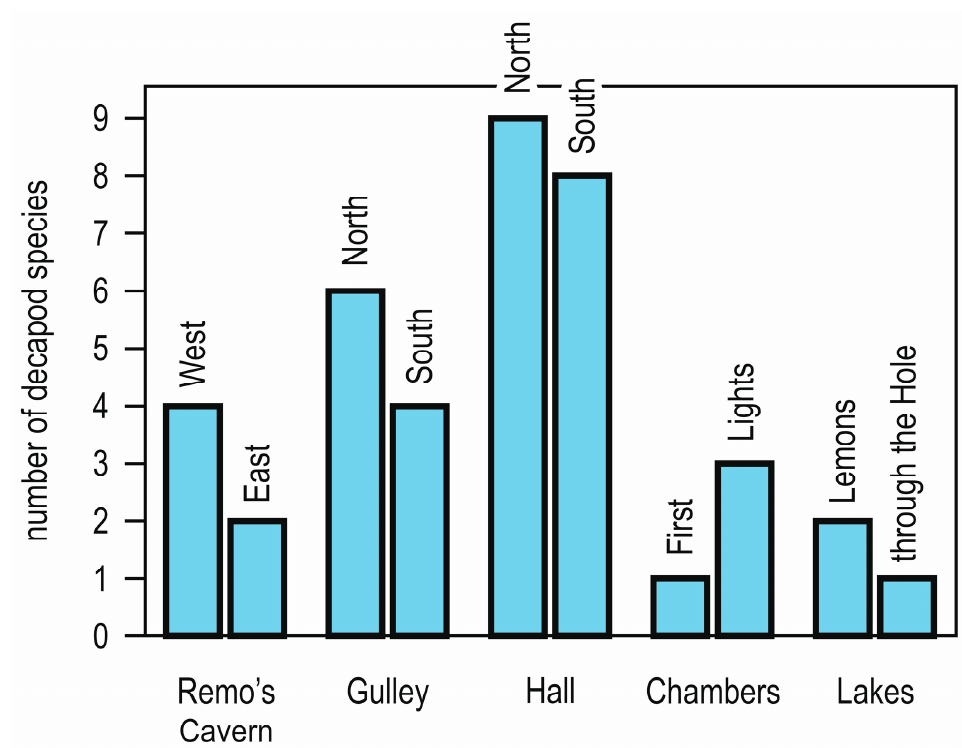
Figure 8. Underwater photographs of decapod species in the Grotta Marina of Bergeggi: ( a ) Herbstia condyliata ; ( b ) Stenopus spinosus ; ( c ) Palaemon serratus ; ( d ) Lysmata seticaudata ; ( e ) Scyllarus arctus ; ( f ) Dromia personata ; ( g ) Clibanarius erythropus (in a shell of Cerithium vulgatum ); ( h ) Inachus dorsettensis ; ( i ) Scyllarides latus .